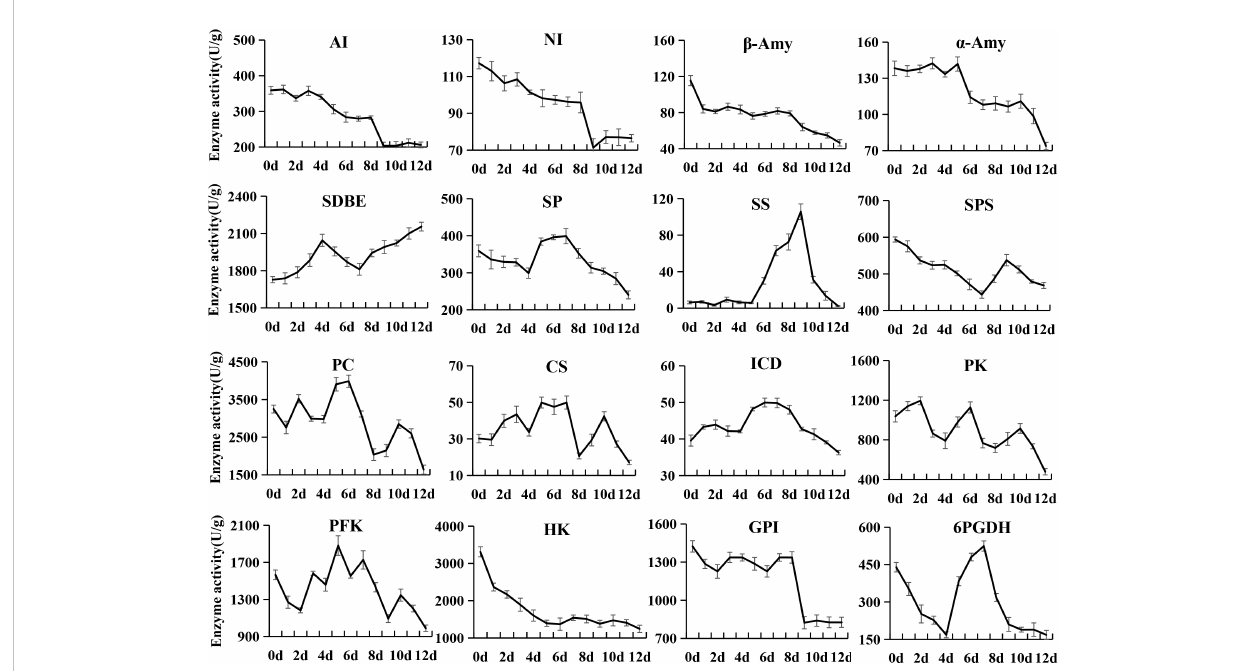
FIGURE 5 Changes in enzyme activities related to sugar and organic acid metabolism in kiwifruit during postharvest ripening. The error bars represent the SD from three